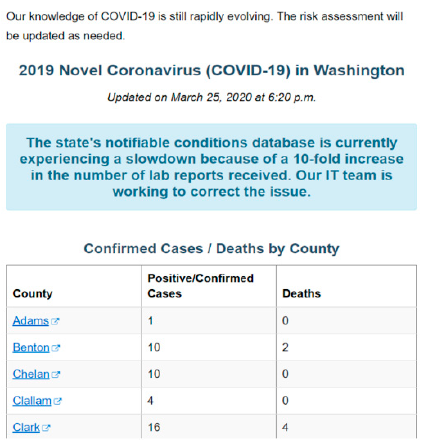
Figure 2. Washington State Department of Health (WSDH) announcement on 25 March 2020. (Source: WSDH).